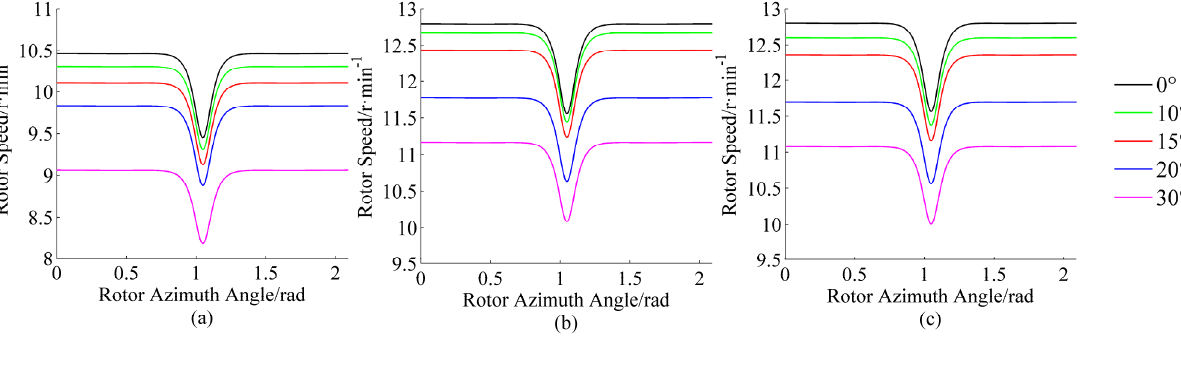
Figure 6. Effects of yaw error on rotor speed by stage: ( a ) Stage II, V H = 7 m/s. ( b )